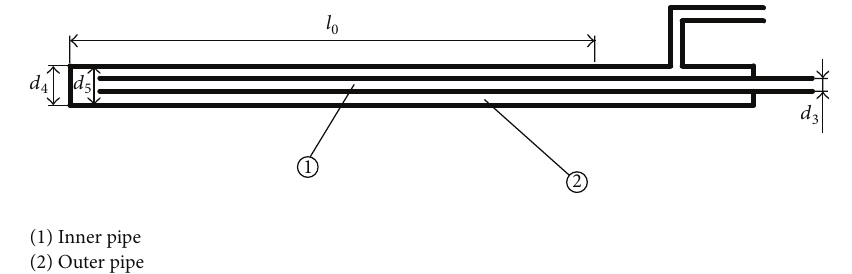
Figure 4: Experimental system II.